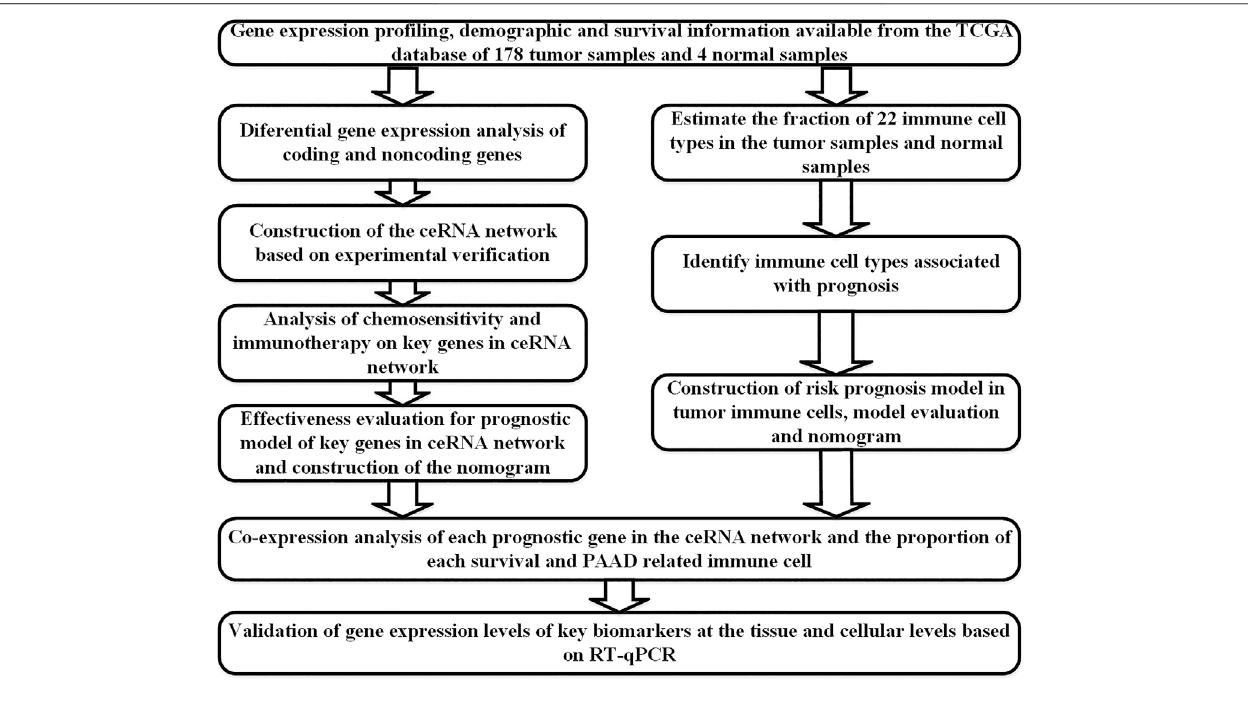
FIGURE 1 | Flow chart of the analytical